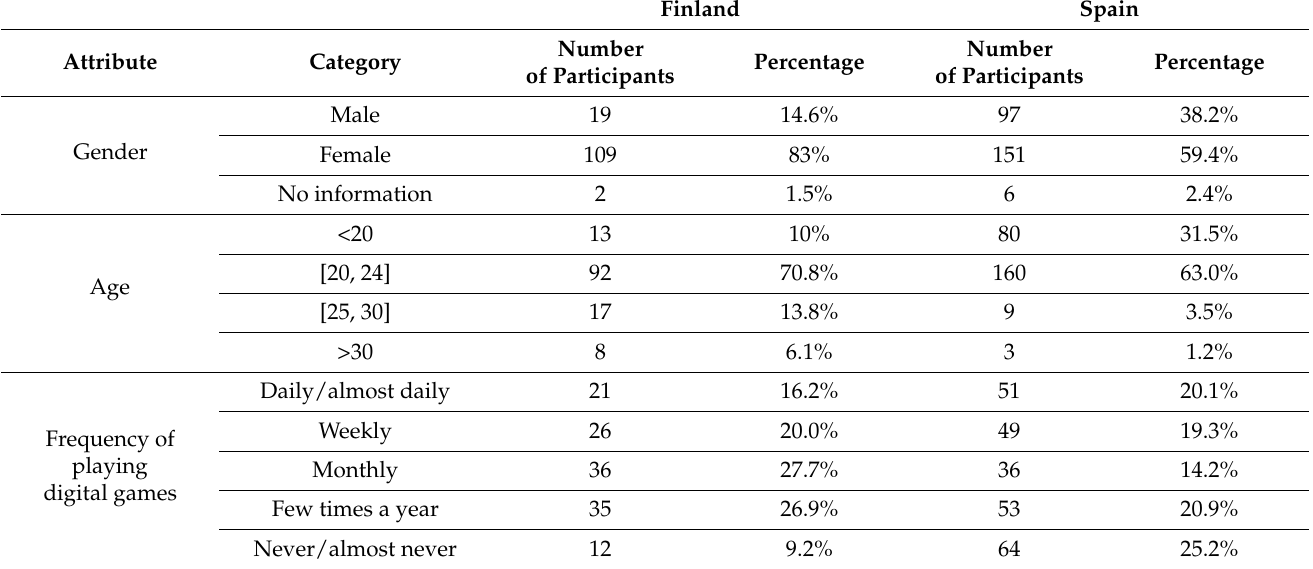
Table 1. Demographic data of the participants (N_Finland = 130, N_Spain = 254). Finland